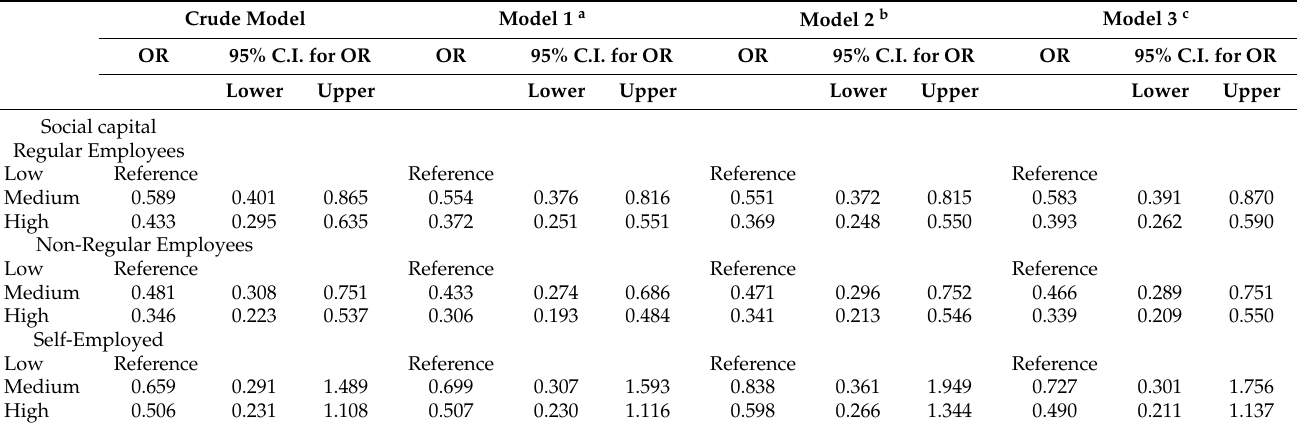
Table 3. Prevalence ratios of social capital for poor self-rated health respondents.